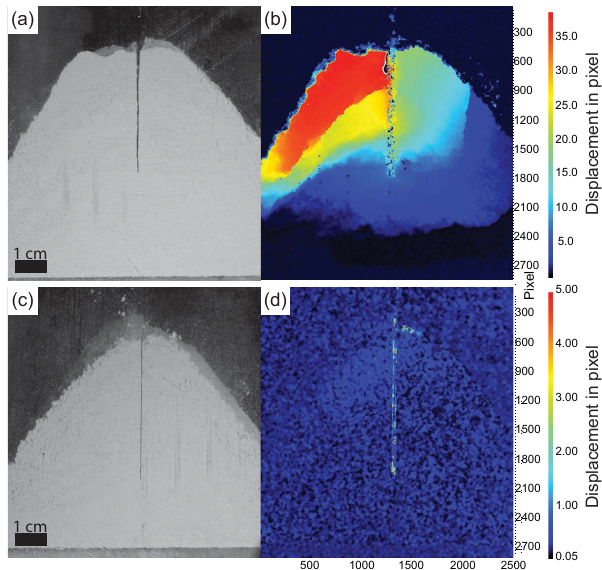
Figure 1. (a) Dimension and principle setup of the deformation ap- paratus. Black bands symbolize paper sheets that are used for joint creation. (b) Experiment after sieving in the hemihydrate powder, with the paper sheets still in place. Paper sheets are removed before deformation begins.